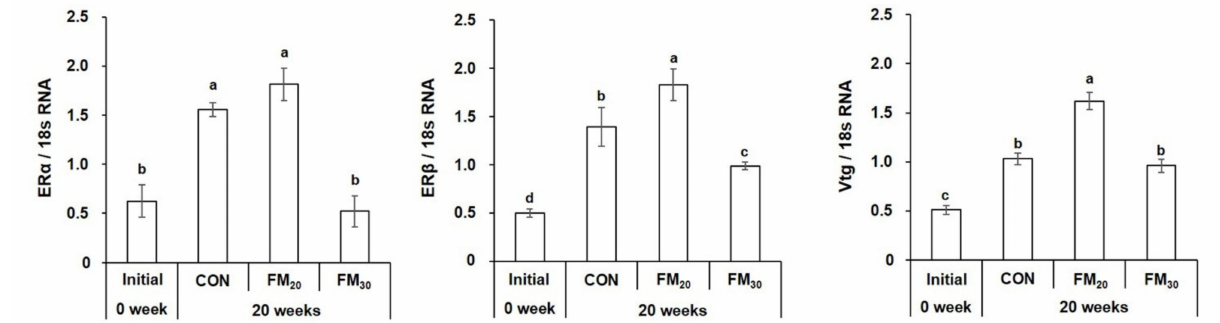
Figure 7. Expression of estrogen receptor (ER) α , ER β , and vitellogenin (Vtg) mRNA in the olive flounder Paralichthys olivaceus. Data are presented as the mean ± SEM ( n = 10). Different letters above the bars indicate signifi- cant differences ( p < 0.05) between groups. CON, control diet; FM 20 , diet with 20% of the fishmeal replaced; FM 30 , diet with 30% of the fishmeal